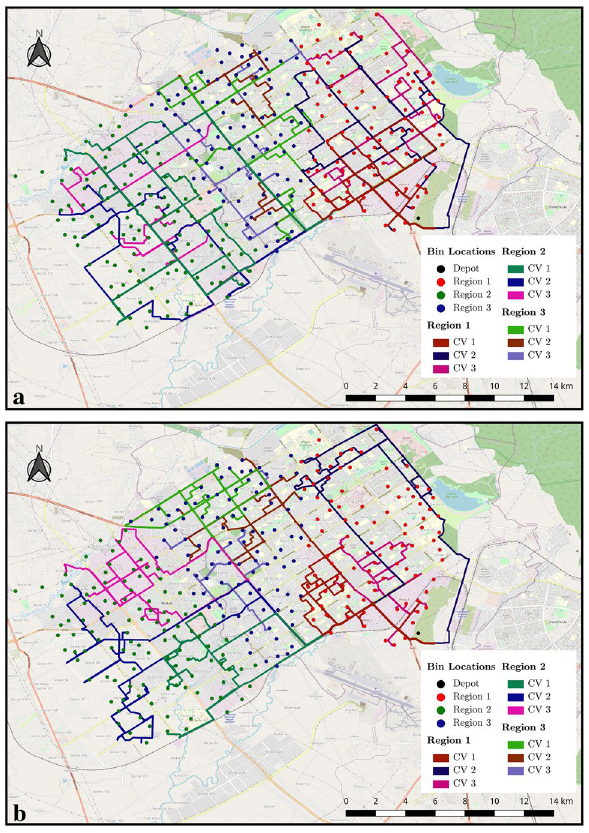
Figure 6. Routes for the case 3 CV per region for ( a ) static and ( b ) dynamic